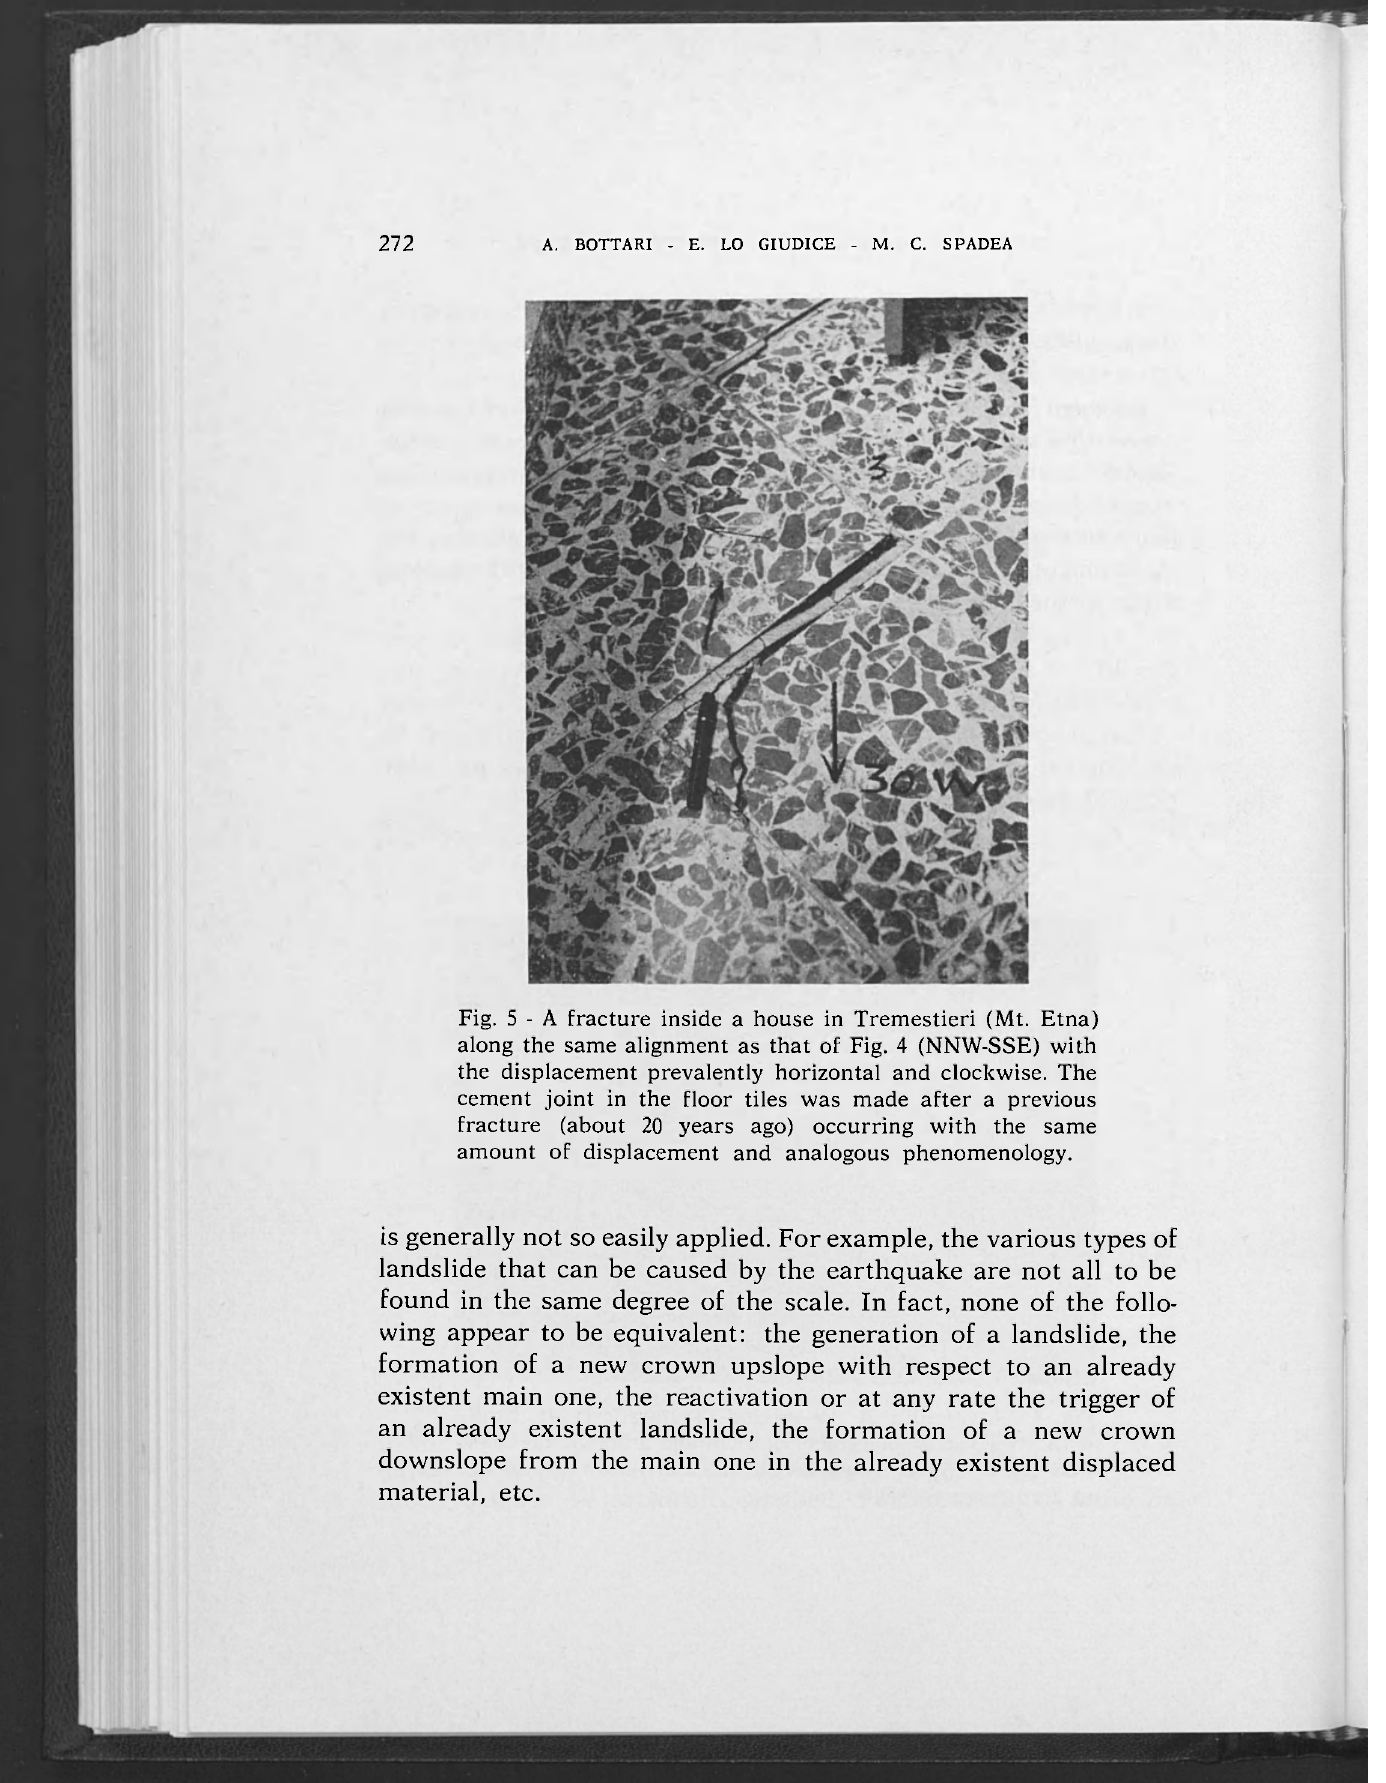
Fig. 5 - A fracture inside a house in Tremestieri (Mt. Etna) along the same alignment as that of Fig. 4 (NNW-SSE) with the displacement prevalently horizontal and clockwise. The cement joint in the floor tiles was made after a previous fracture (about 20 years ago) occurring with the same amount of displacement and analogous